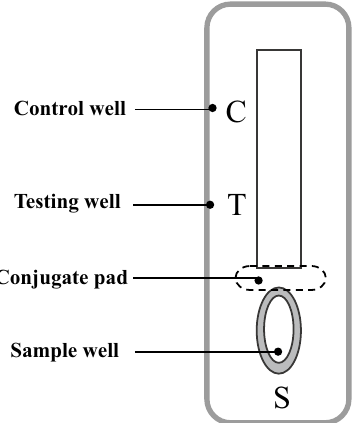
Fig. 2 A general configuration of the LFIA test strip. To initiate LFIA, the sample of interest is applied to the sample pad and then flows through the sample pad to the conjugate release pad, rehydrating the analyte-specific antibodies or the attached virus antigen. The associated antibody or antigen, together with its target, flows towards the detector zone of the strip after the contacts. As the complex moves up the membrane, it passes the immobilised analyte-specific antibody, which recognises and binds to it, resulting in a coloured line. The control antibody recognises and captures the control well portion of the antibody detector, resulting in a coloured line that eventually serves as a control. Results are interpreted on the reaction matrix as the presence or absence of lines of captured conjugate, read either by Ching [56]